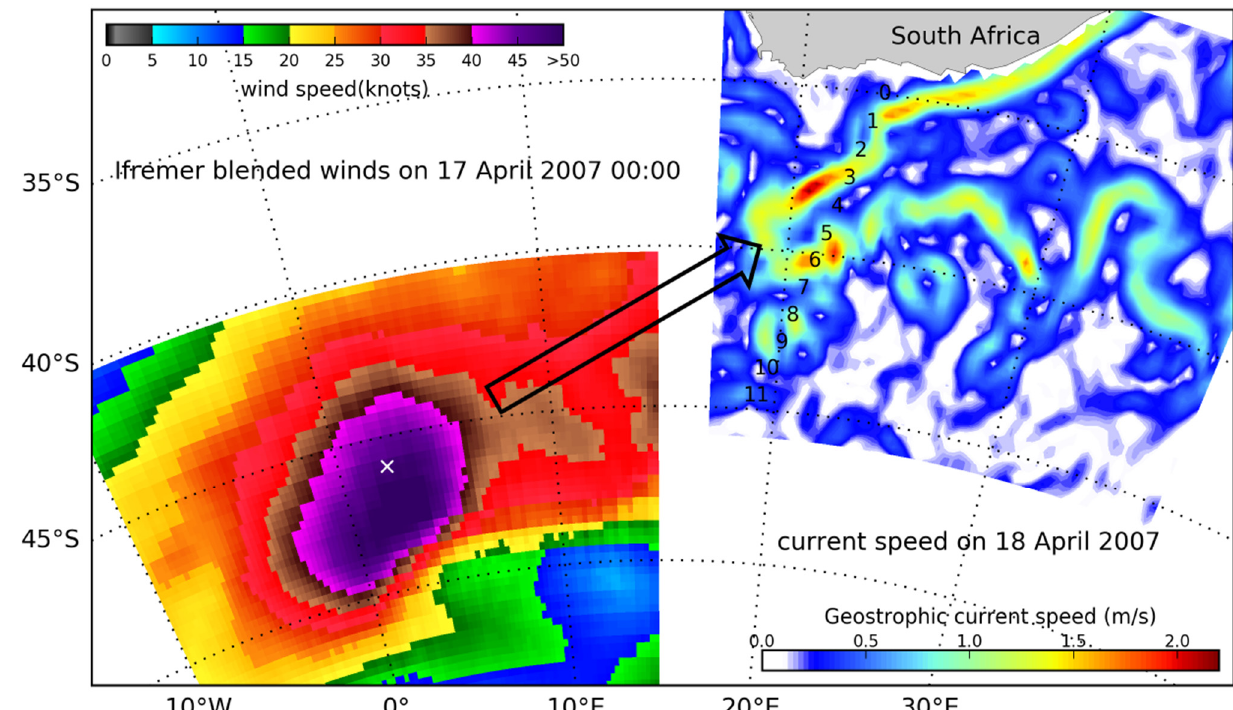
Figure 5. Typical Example of crossing swells in Region B. Right of map illustrates ASAR observed swells (numbered from 0 to 11) in the Agulhas Current (color-coded GlobCurrent current speed) on 18 April 2007. These swells were originated from the extra-tropical cyclone on 17 April (on the left, with color representing Ifremer blended winds, and white cross indicating “fireworks” determined swell origin).